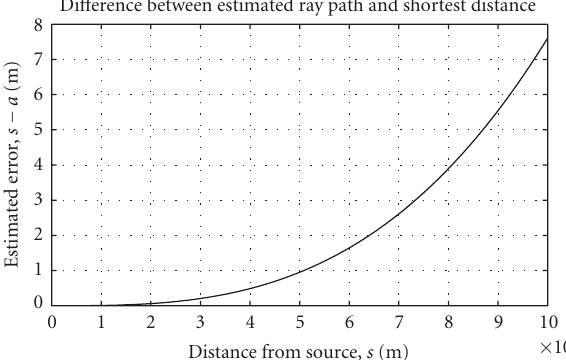
Figure 2: Error from shortest distance due to refracted propagation